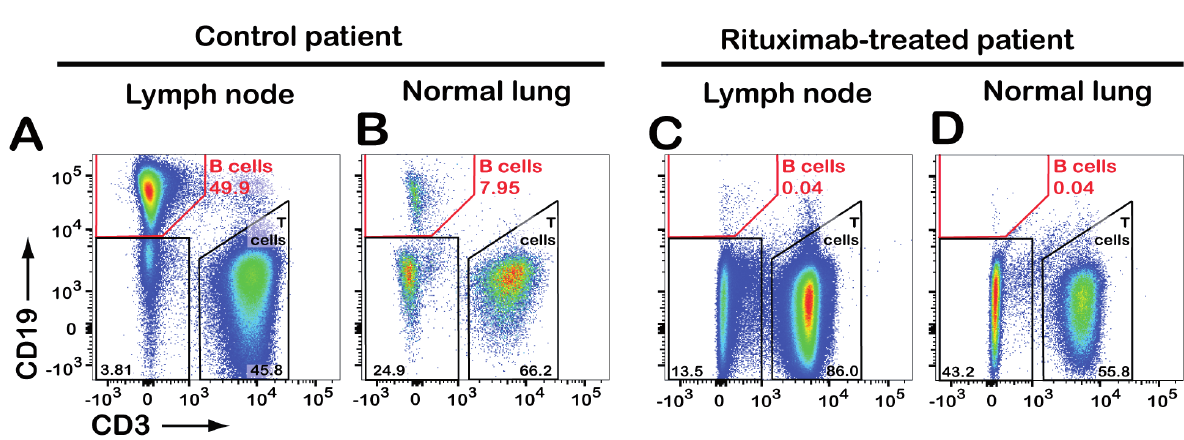
Figure 2. Rituximab depletes B cells in lung-associated lymph node and normal lung tissue. Upon chest surgery for removal of tumor- containing lung lobe from a patient previously treated with rituximab, a lung-associated lymph node and normal lung tissue samples were analyzed by flow cytometry. Results from a control lung cancer patient (not treated with rituximab) are shown for comparison. Both patients were diagnosed with lung adenocarcinoma. Live leukocytes (CD45-positive, propidium iodide-negative) were gated and analyzed further for expression of CD19 (B cells) and CD3 (T cells). Numbers indicate the percentage of cells detected in each